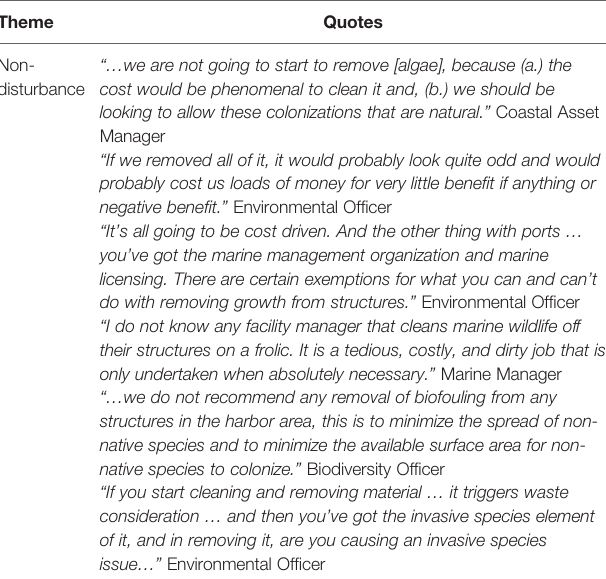
TABLE 8 | Quotes illustrating why respondents do not remove marine growth from